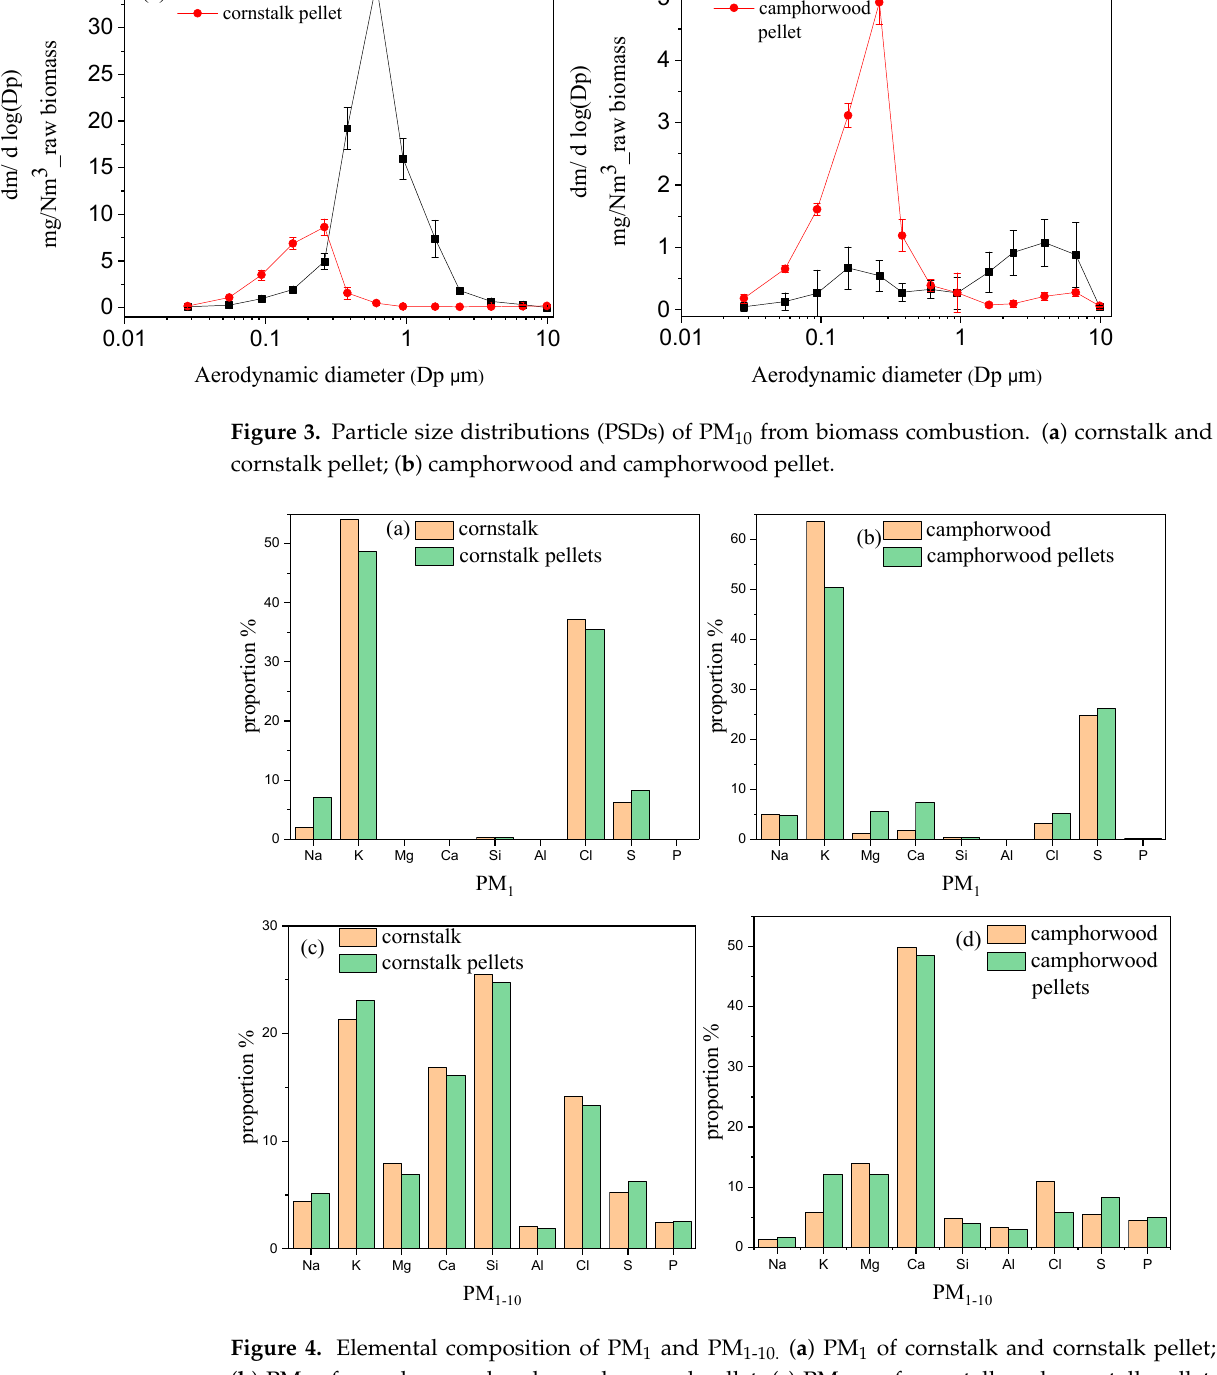
Figure 4. Elemental composition of PM 1 and PM 1-10. ( a ) PM 1 of cornstalk and cornstalk pellet; ( b ) PM 1 of camphorwood and camphorwood pellet; ( c ) PM 1-10 of cornstalk and cornstalk pellet; ( d ) PM 1-10 of camphorwood and camphorwood pellet. Table 6. Molar ratio between main elements in PM.